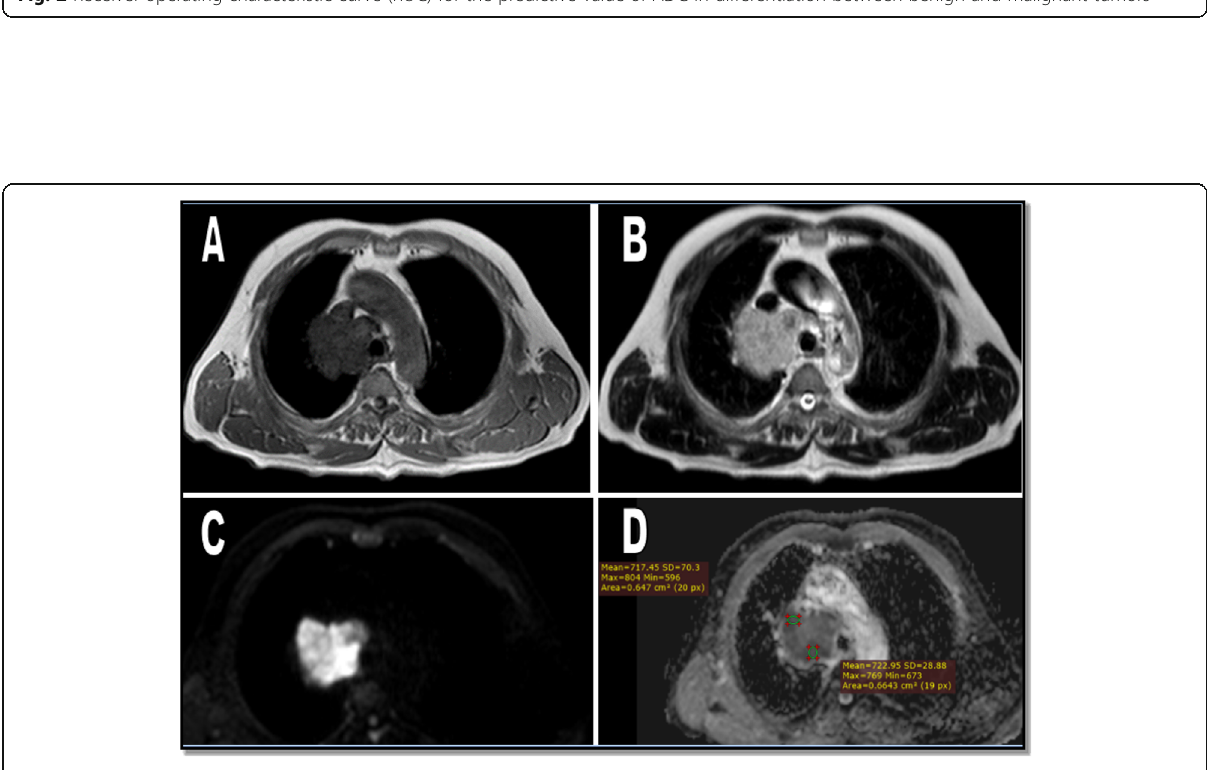
Fig. 3 Case of undifferentiated small cell lung cancer. A 69-year-old male presented with chest pain. MRI chest ( a ) axial T1WI, ( b ) axialT2WI, ( c ) DWI, ( d ) ADC map showing right side mediastinal soft tissue mass eliciting low signal in T1WI, high signal in T2WI and showing restricted diffusion (high signal on DWI and low signal on ADC map) with ADC value 0.7 × 10 − 3 mm 2